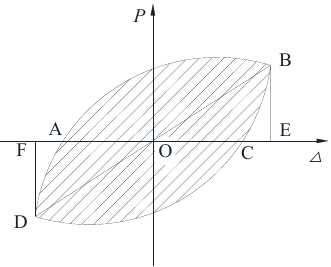
Figure 13. The equivalent viscous damping coefficient.